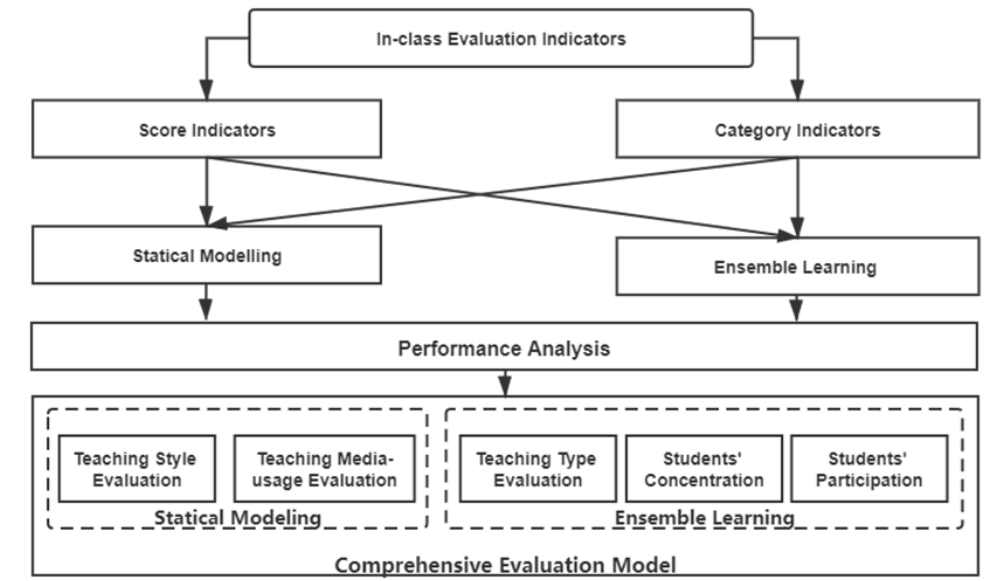
Figure 8. Process chart of the performance analysis experiment.